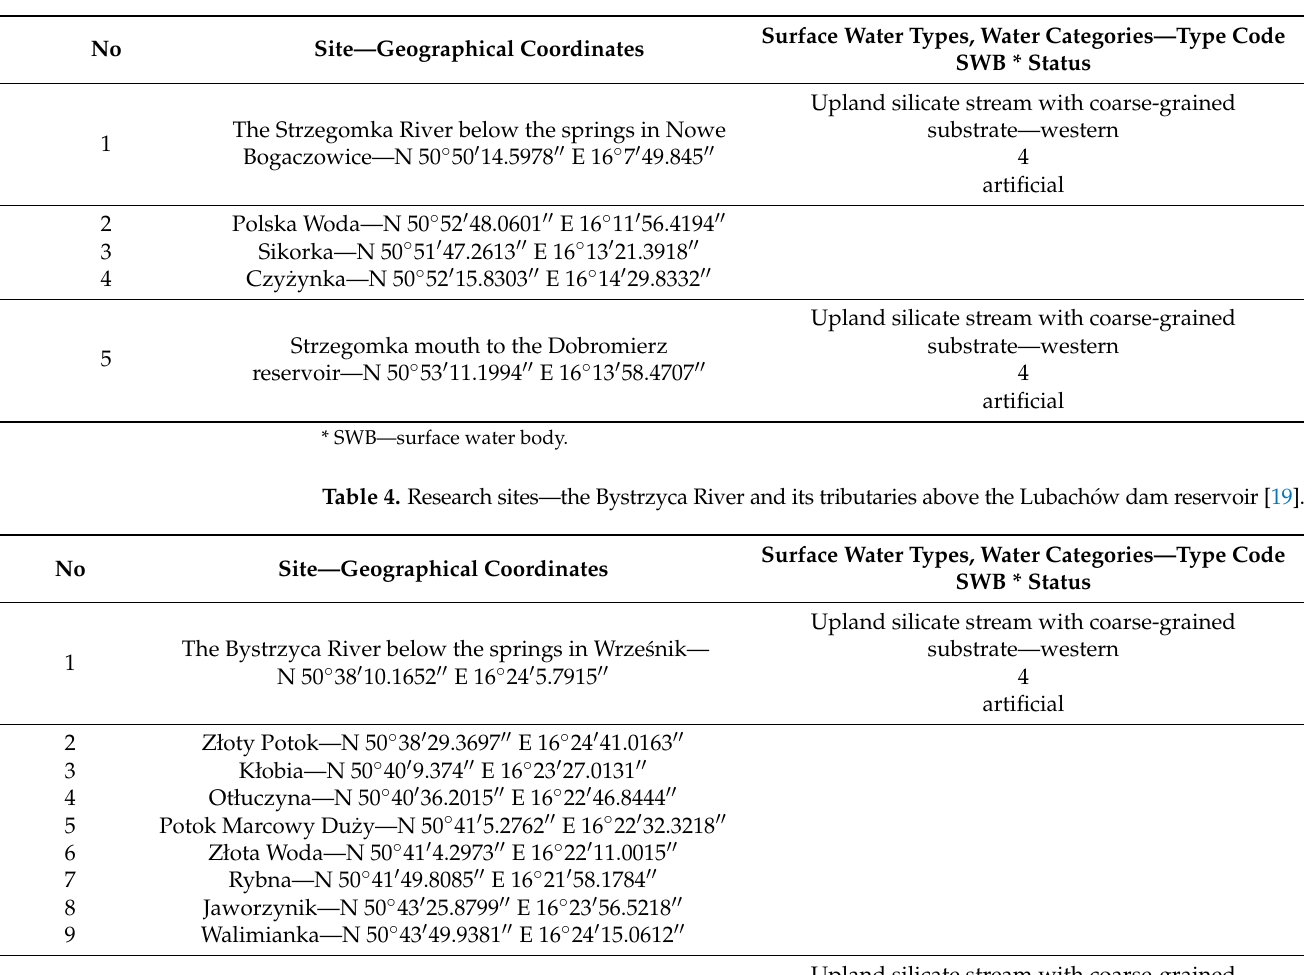
Table 3. Research sites—the Strzegomka River and its tributaries above the Dobromierz dam reservoir [19].